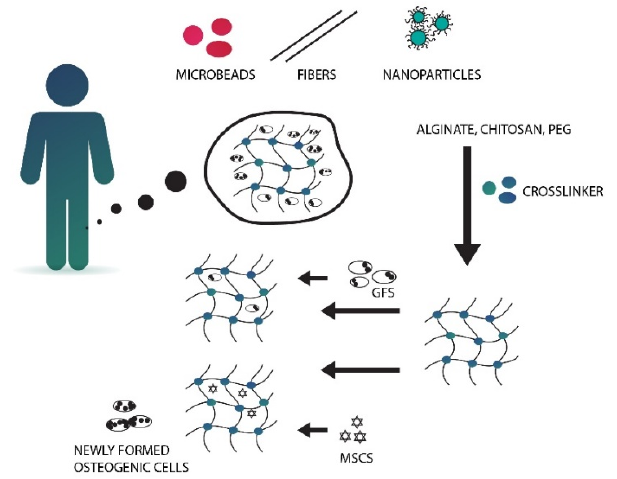
Figure 7. Schematic illustration of hydrogel-assisted bone regeneration. MSC, mesenchymal stem cell; GF, growth factor.